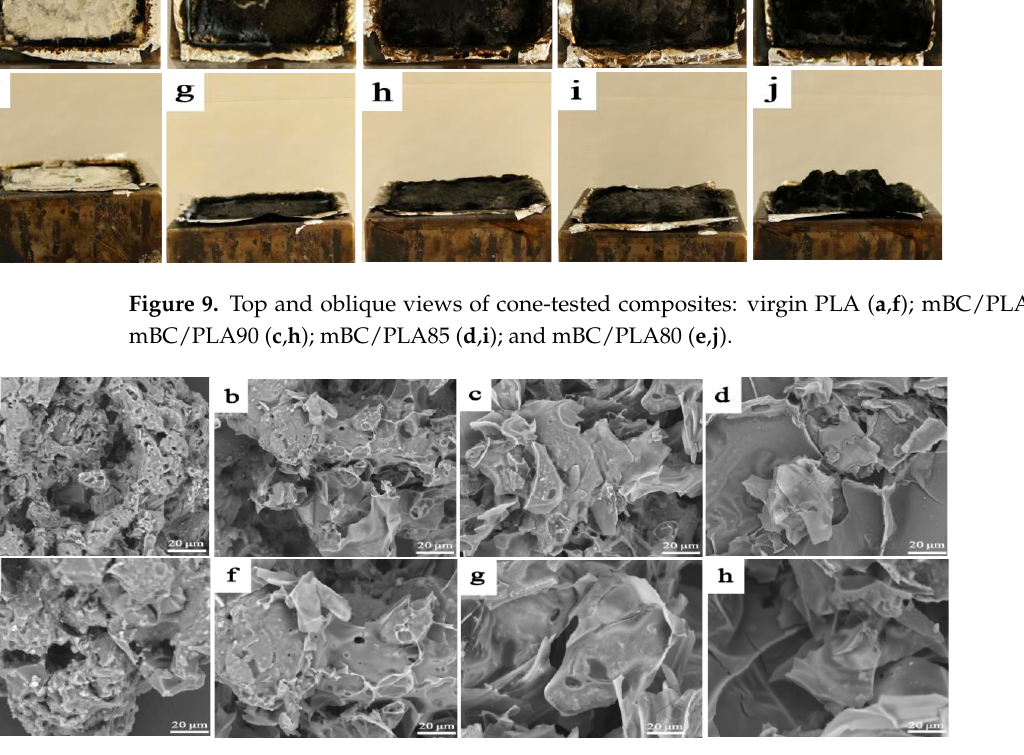
Figure 9. Top and oblique views of cone-tested composites: virgin PLA ( a , f ); mBC/PLA95 ( b , g ); mBC/PLA90 ( c , h ); mBC/PLA85 ( d , i ); and mBC/PLA80 ( e , j ).